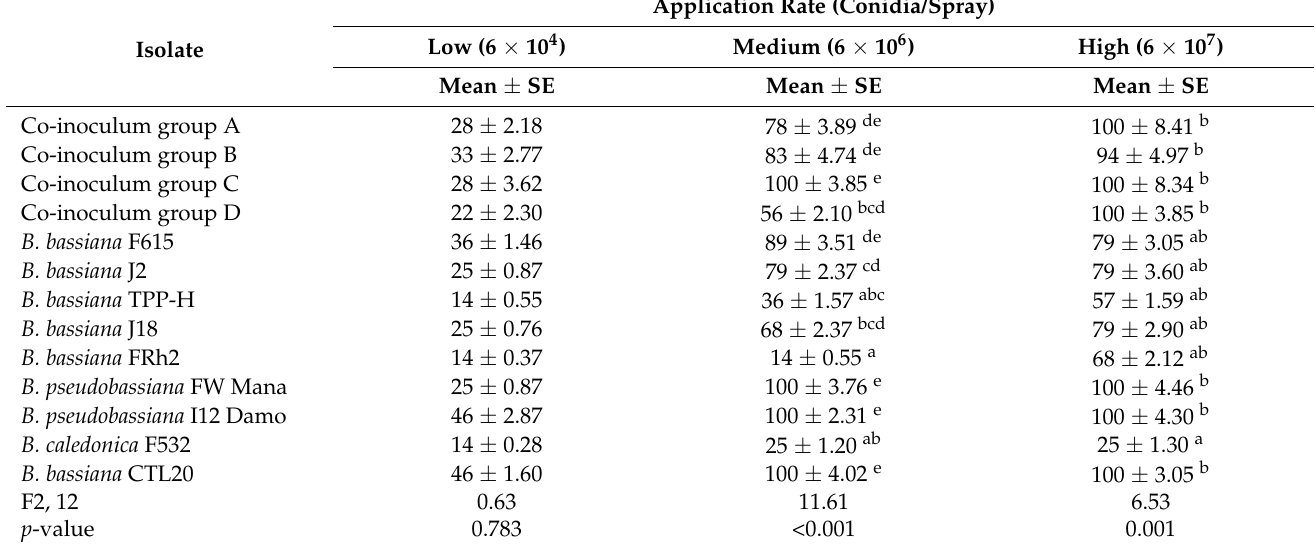
Table 3. Larval mortality (% ± SE) of diamondback moth seven days after application with selected Beauveria isolates at three application rates. Mortality rates were corrected against the control mortality rate using Abbott’s formula. Values in a column followed by the same letter are not significantly different ( p > 0.05) according to Tukey’s HSD test.